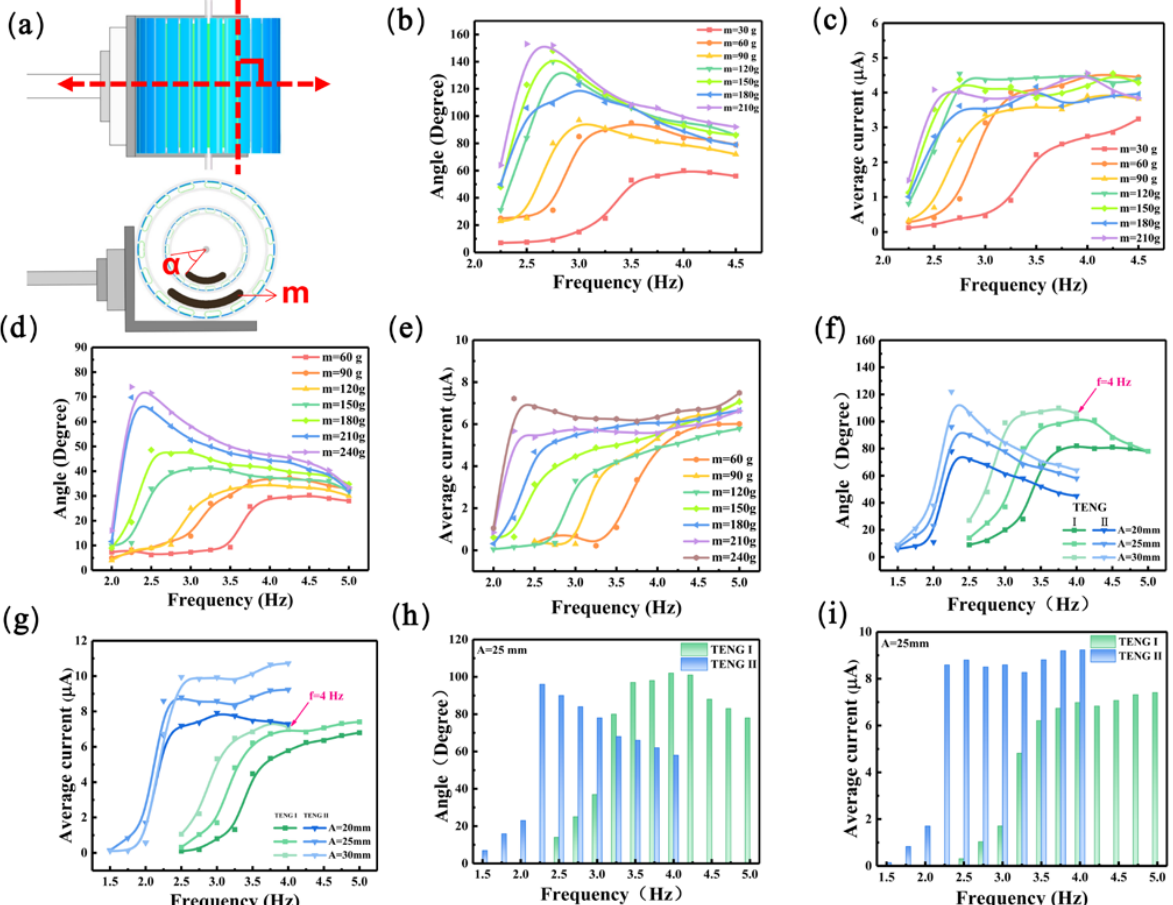
Figure 3. The effect of the mass block and excitation amplitude on the output of MC-TENG. ( a ) Relative position of the MC-TENG to the linear motor. ( b – e ) Variation in the mass block mass in each TENG unit concerning its swing angle and the average TENG current value. ( f , g ) The effect of different excitation amplitude conditions on the swing angle of the mass block in the two TENG units and the average current value. ( h , i ) Comparison of the outputs of the two TENG units at different frequencies.